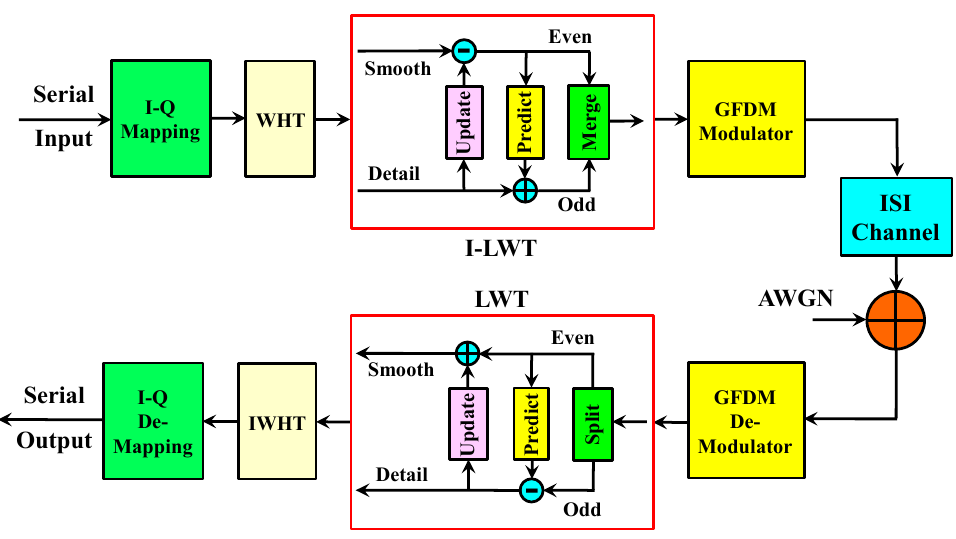
Figure 3. The transceiver structure of the proposed waveform.